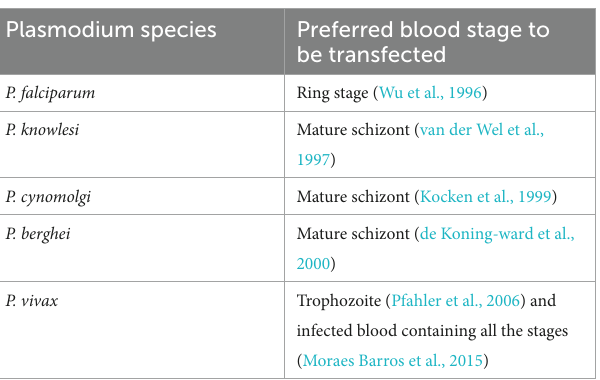
TABLE 1 Preferred blood stage for transfection in different Plasmodium